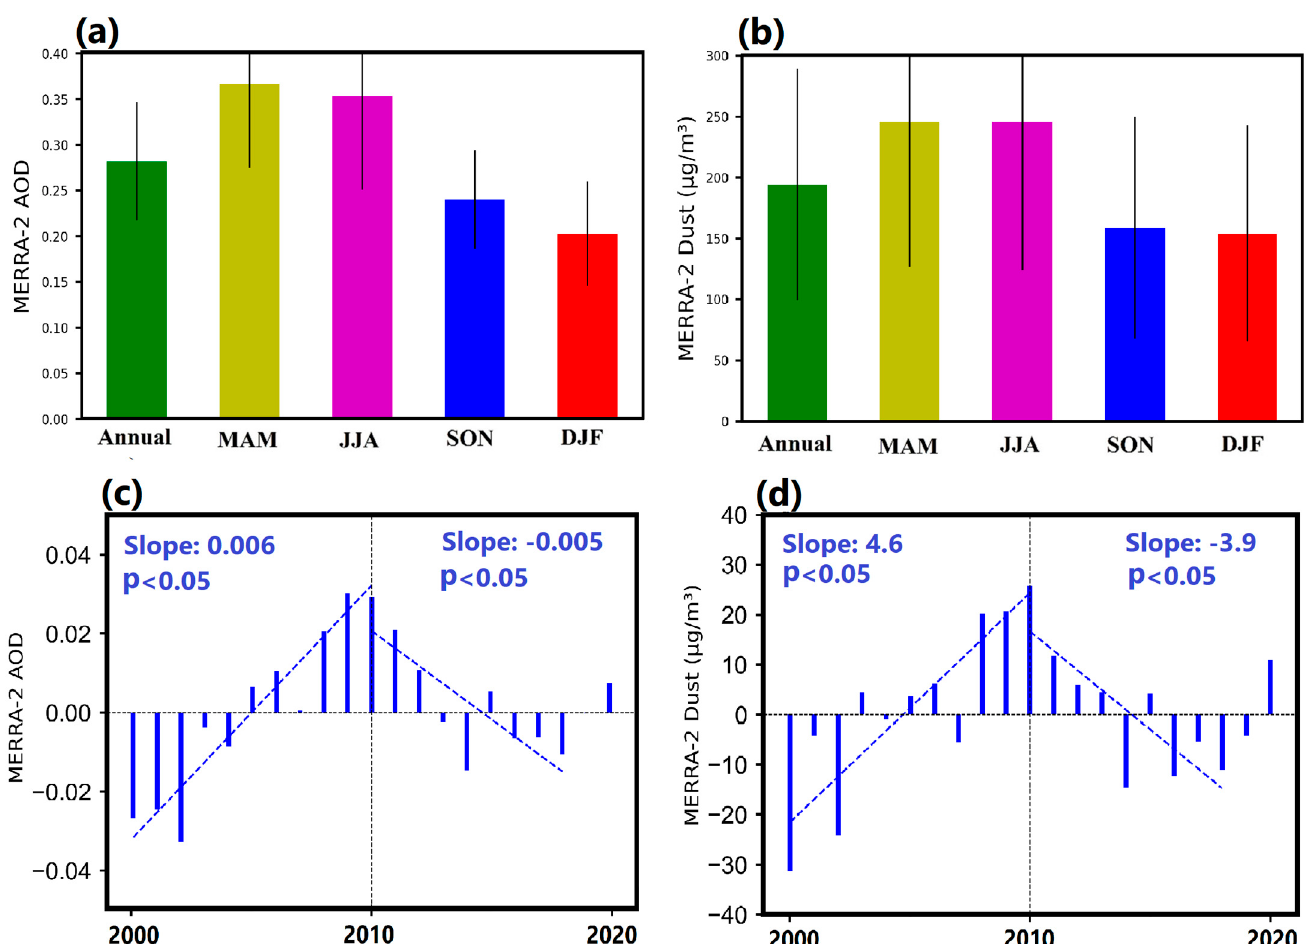
Figure 3. Annual and seasonal variations in the MERRA-2 AOD ( a ) and MERRA-2 dust concentrations ( b ) over Iran during the period 2000–2020. The vertical bars represent one standard deviation of the mean. Time series of the MERRA-2 spatial-averaged AOD anomalies ( c ) and dust concentration anomalies ( d ) over Iran during the winter (DJF) season. Dashed lines represent the trends ( p < 0.05) during the first (until 2010) and second (until 2018) periods.